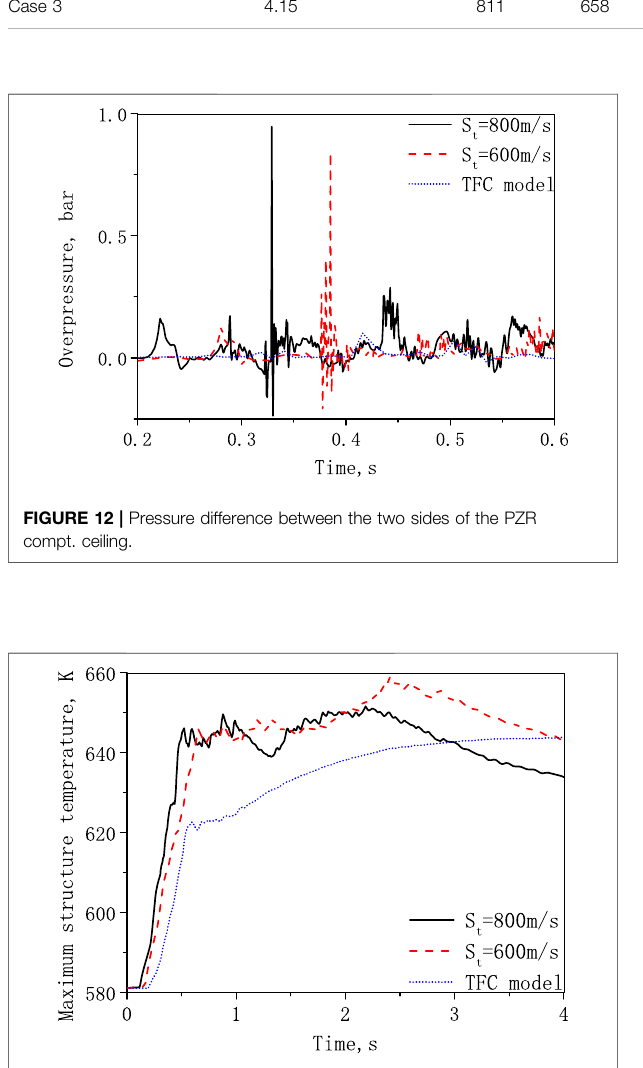
FIGURE13| Maximumtemperatureonthecontainmentstructuresurface.